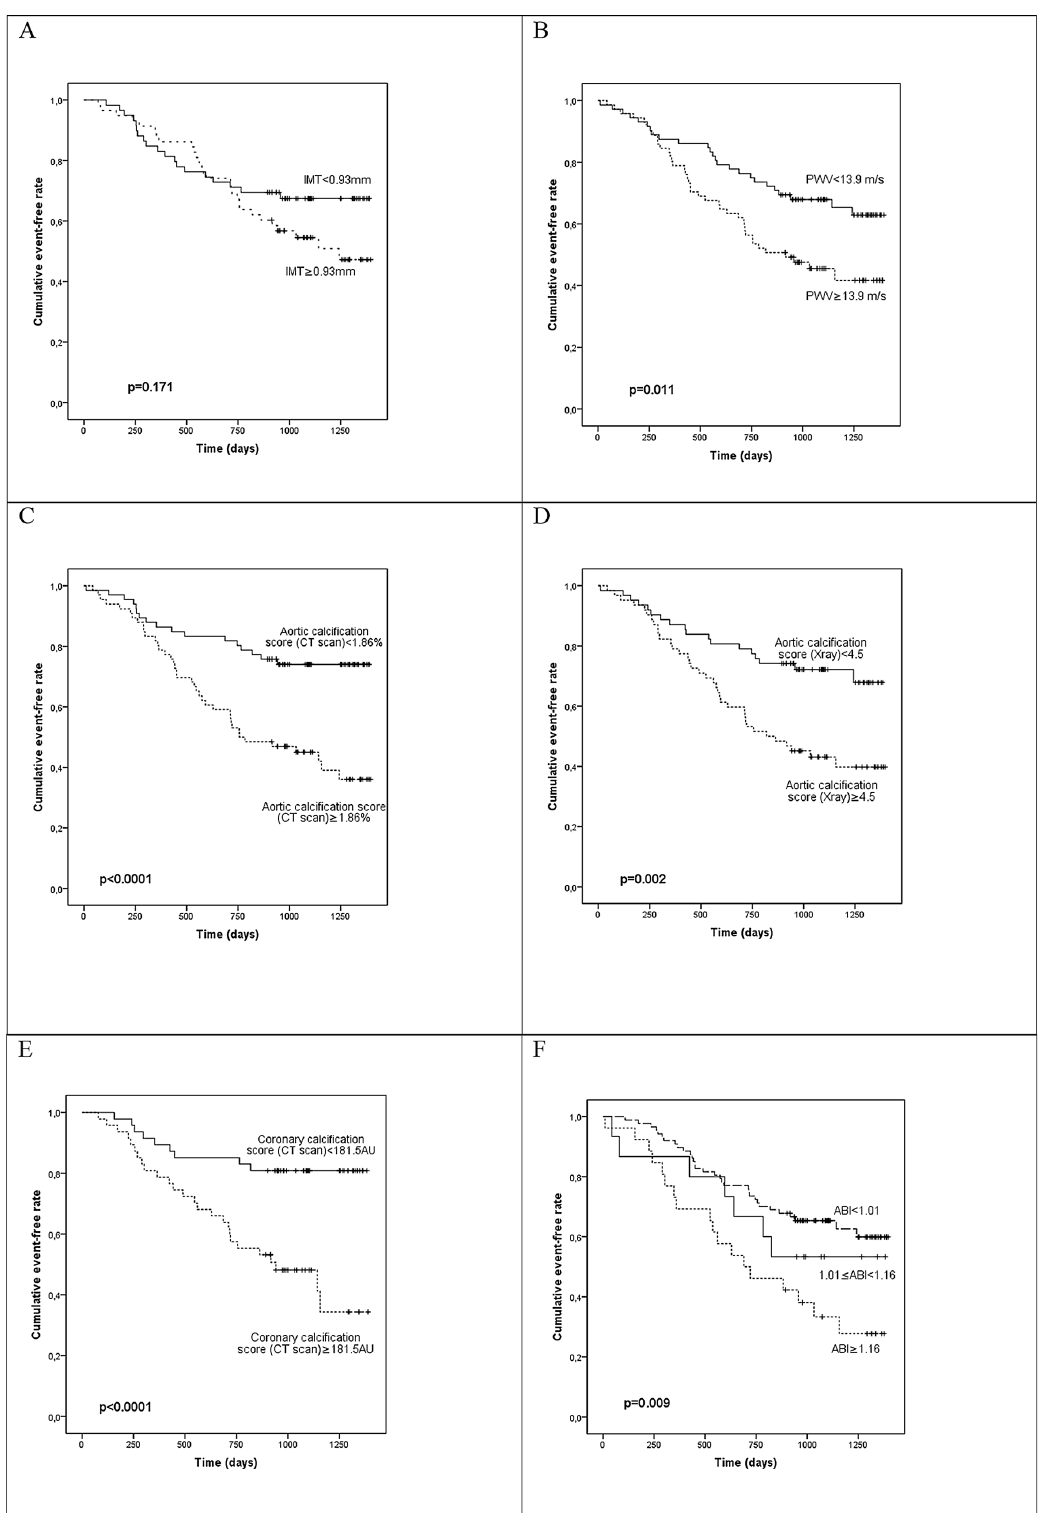
Fig 2. Unadjusted Kaplan-Meier cumulative event curves for all-cause mortality and the first non-fatal CV event, as a function of the median value of the (A) IMT, (B) PWV, (C) aortic calcification score (CT scan), (D) aortic calcification score (X-ray), (E) coronary artery calcification score (CT scan), and ABI tertile